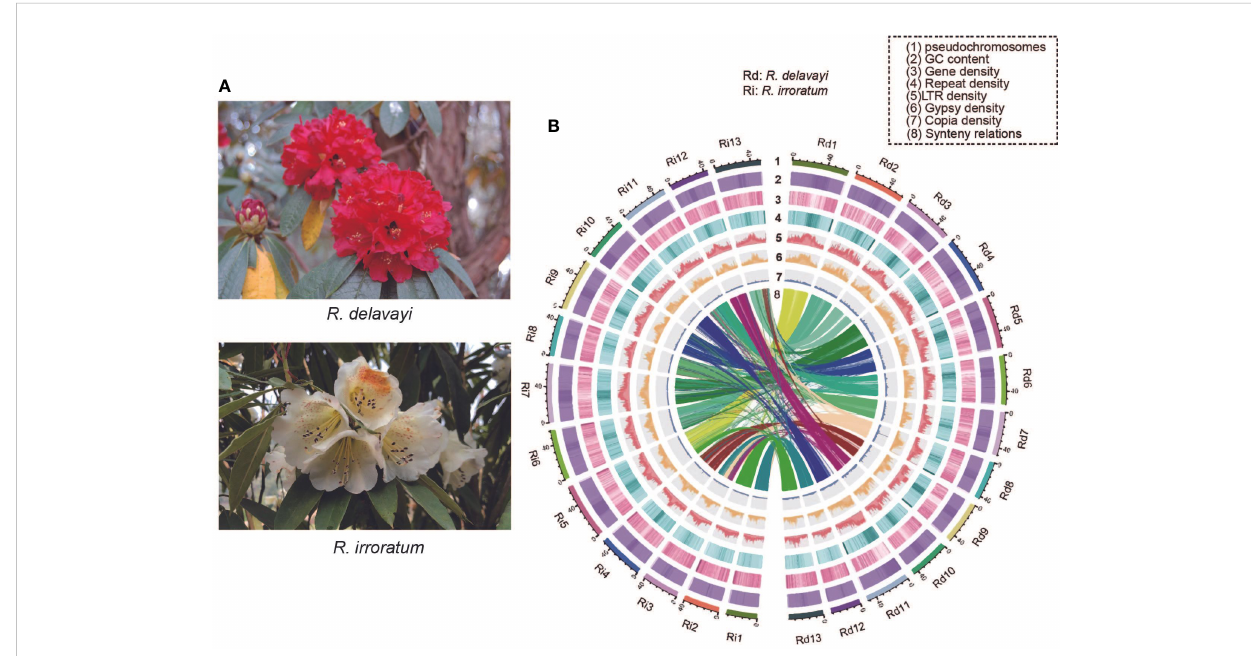
FIGURE 1 Flower morphology and genome features of R. delavayi and R. irroratum . (A) R. delavayi are characterized by bright red fl owers and R. irroratum typically has pale yellow fl owers. Photos: Hong Yang and Yan-Ting Hu, Baili Rhododendron Nature Reserve, Guizhou, China. (B) The landscape of the genome assemblies and annotations for R. delavayi and R. irroratum. The density was calculated in 100-kb sliding windows (Rd: R. delavayi and Ri: R. irroratum